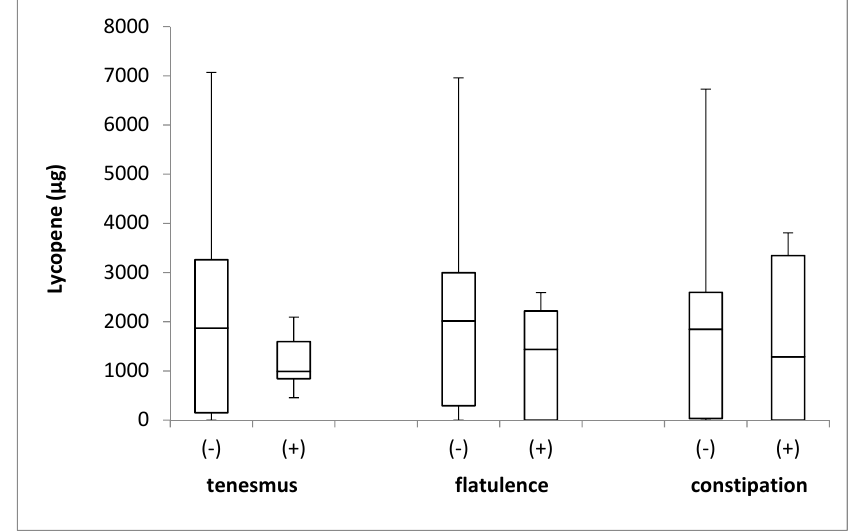
Figure 5. The box plots of β -cryptoxanthin intake in groups of individuals stratified by the analyzed symptoms of tenesmus, flatulence and constipation. (-) symptom not declared; (+) symptom declared. The lycopene intake in the groups of individuals stratified by the incidence of tenesmus, flatulence, and constipation is presented in Figure 6. No differences in the levels of lycopene intake were identified between the groups, with respect to the incidence of tenesmus ( p = 0.290; Mann– Whitney U test), flatulence ( p = 0.216; Mann–Whitney U test), and constipation ( p = 0.785; Mann– Whitney U test).